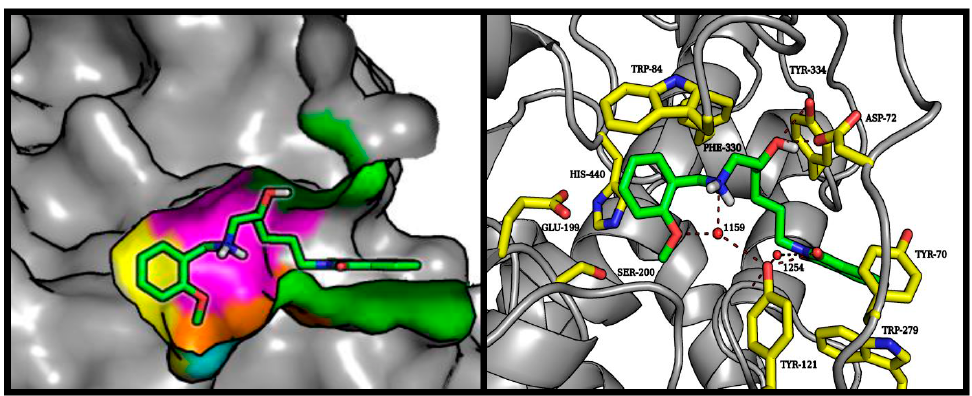
Figure 3. Left panel: illustrative location of compound 15 (green sticks) in the active site of AChE. Active site elements are color-coded: yellow: catalytic triad; magenta: anionic site; orange: acyl pocket; cyan: oxyanion hole; green: PAS. Right panel: detailed visualization of compound 15 (green) interactions with amino acids (yellow) belonging to the active site of AChE, including the conserved waters (red balls).